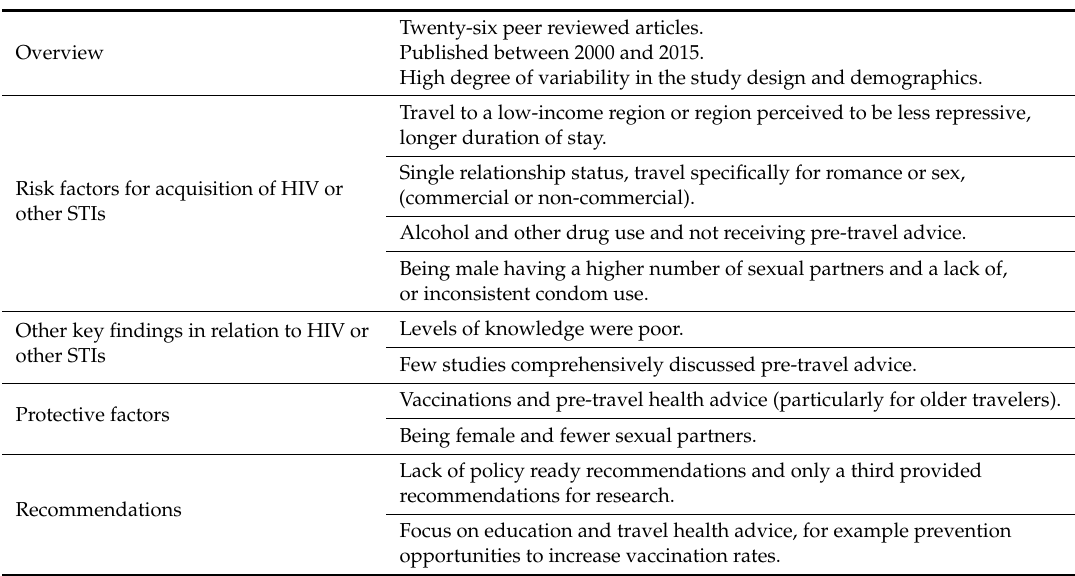
Table 2. Results